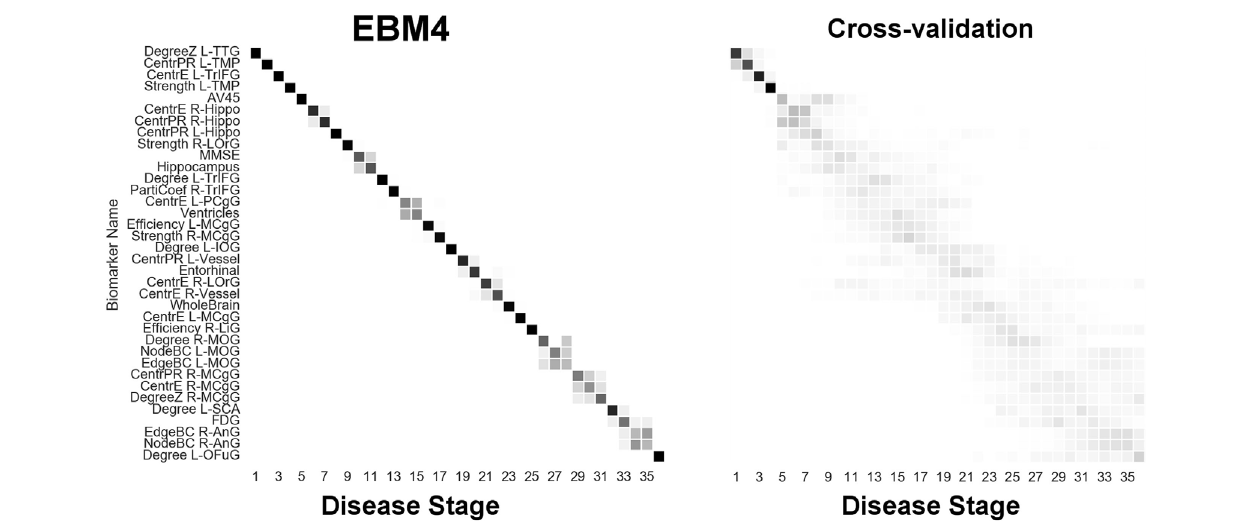
FigUre 8 | EBM for all biomarkers considered, including hubs and centrality in the brain’s anatomical network, along with selected standard (non-network) biomarkers, built on data from our anatomical connectome cohort, The168 . Left panel: left-right positional variance of the maximum-likelihood sequence. Right panel: cross-validation of the sequence from bootstrapping. Abbreviations as in Figures 6 and 7